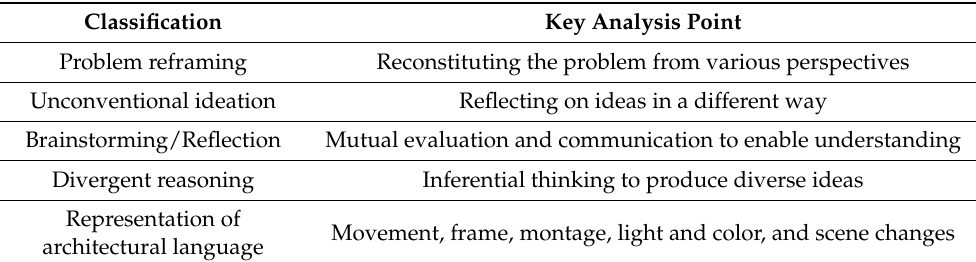
Table 3. A framework for analyzing the features of visual